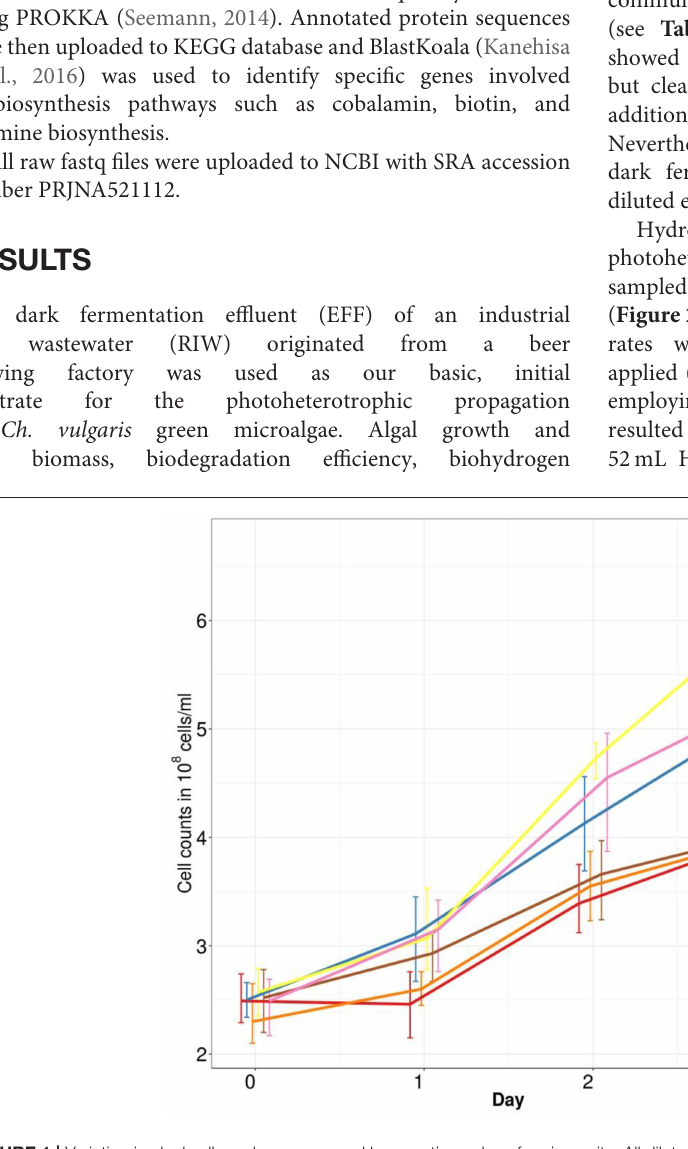
Frontiers in Energy Research |